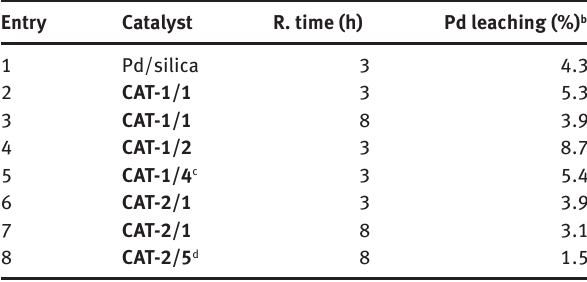
Table 2: Leaching of palladium during recirculation experiments for the aminocarbonylation of iodobenzene ( 1 ) with morpholine ( 2 ) a .